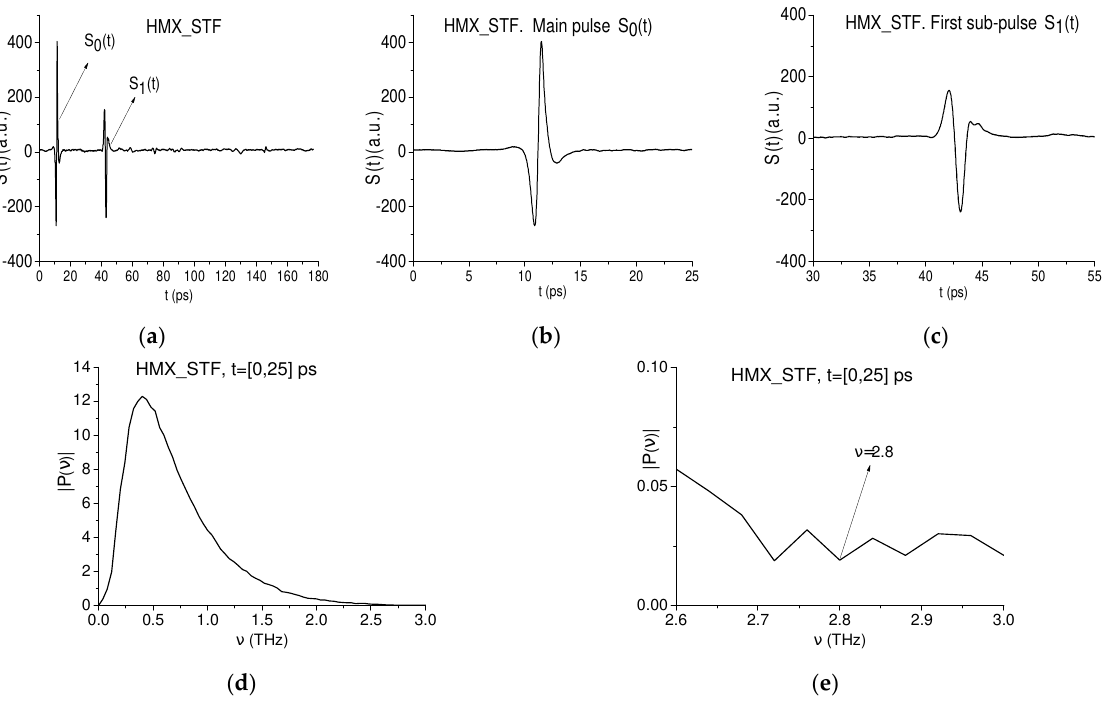
Figure 22. Reflected THz signal HMX_STF ( a ) [51] in the long-time interval t = [0, 180] ps; the main pulse 0 ( ) S t in the time interval t = [0, 25] ps ( b ); the first sub-pulse 1 ( ) S t in the time interval t = [30, 55] ps ( c ). Fourier spectrum of the HMX_STF main pulse in the frequency ranges ν = [0.0, 3.0] THz ( d ), [2.6, 3.0] THz ( e